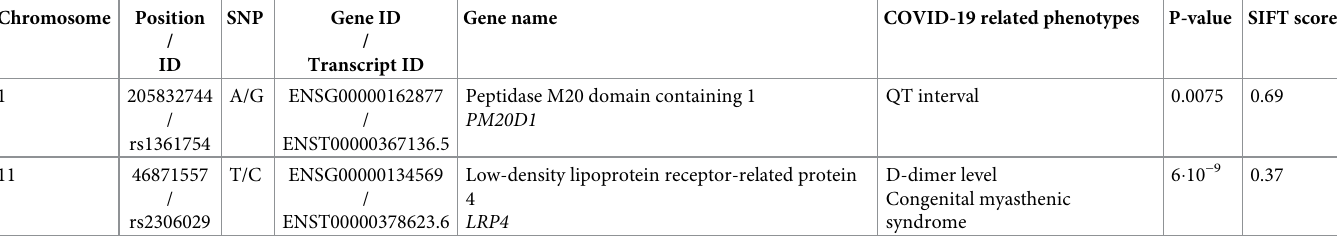
Table 1. SNPs with a potential causal function on a severe outcome of COVID–19 infection. Chromosome Position